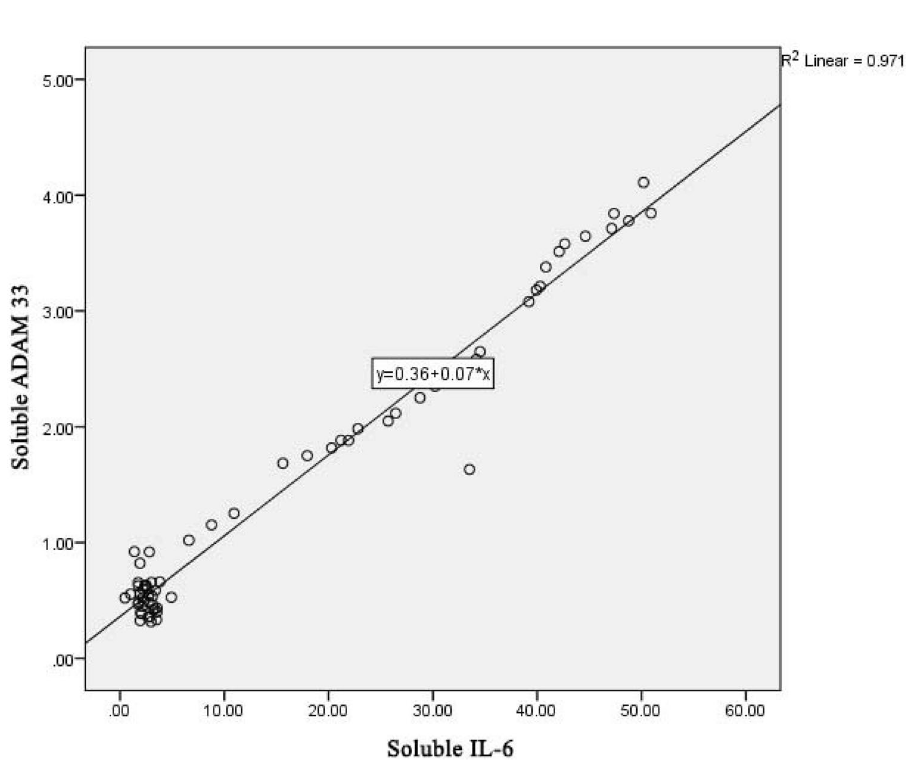
Figure 3. Linear regression graph between IL-6 and ADAM33 level in COPD